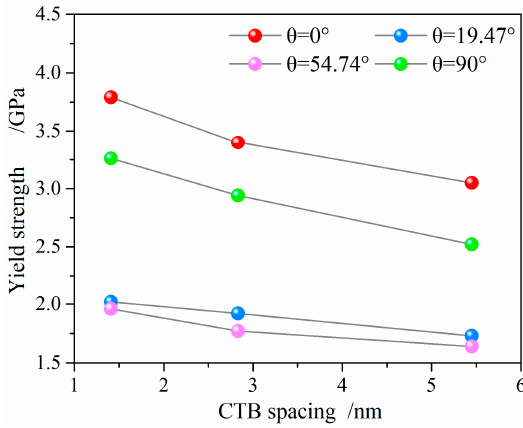
Figure 3. Yield strength as a function of twin orientation and spacing.